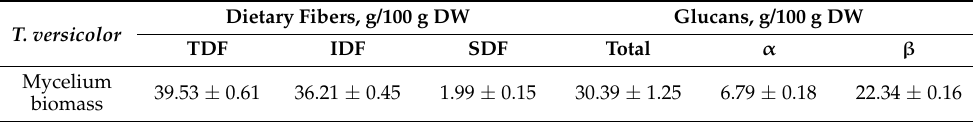
Table 1. Dietary fiber and glucan content in the mycelium biomass of T. versicolor NBIMCC 8939. Dietary Fibers, g/100 g DW Glucans, g/100 g DW T. versicolor TDF IDF SDF Total α β Mycelium 39.53 ± biomass